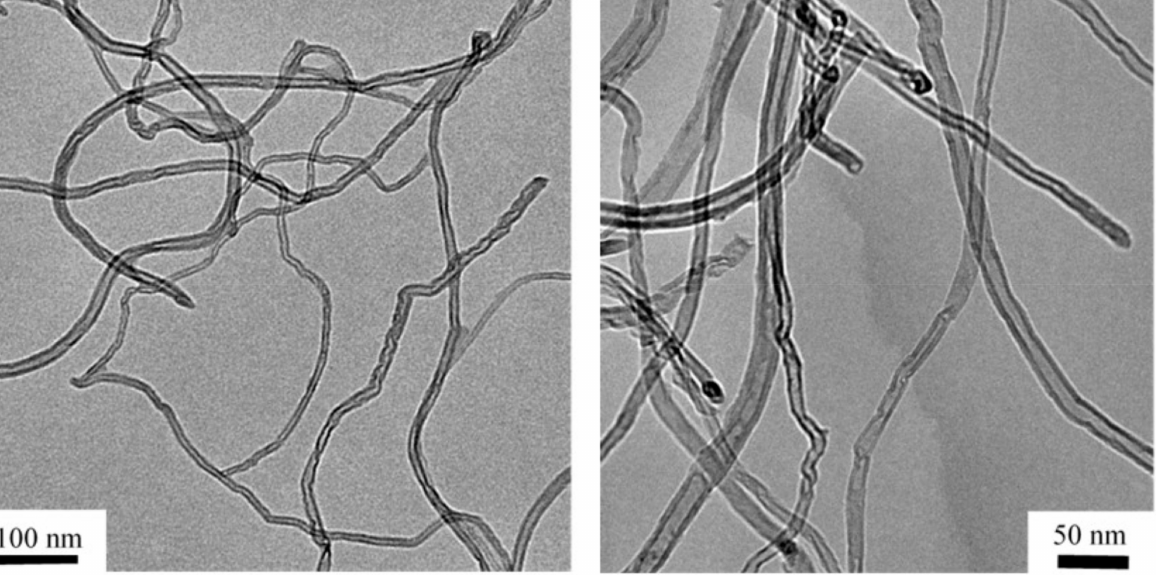
Figure 1. TEM images of pristine NanoIntegris (MW24-170) MWCNTs, deposited on TEM grid from dispersion in DMF without added